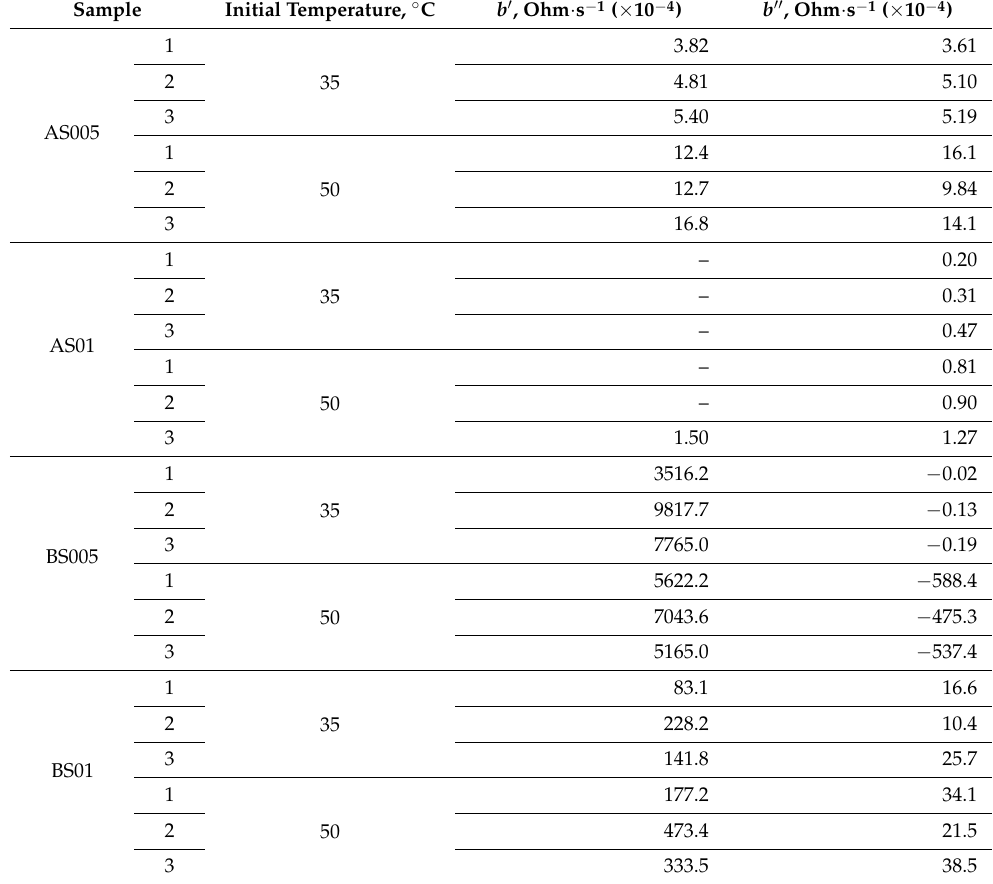
Figure 8. ( a ) Representative variations of resistance and reactance at 1 kHz during the cooling down of one sample AS005 pre-conditioned at 50 ◦ C and ( b ) temperature variations measured by two thermocouples (affixed to the sample surfaces). Table 3. Monitoring of the cooling down through AC impedance at 1 kHz without application of compressive load: Coefficients b (cid:48) and b (cid:48)(cid:48)